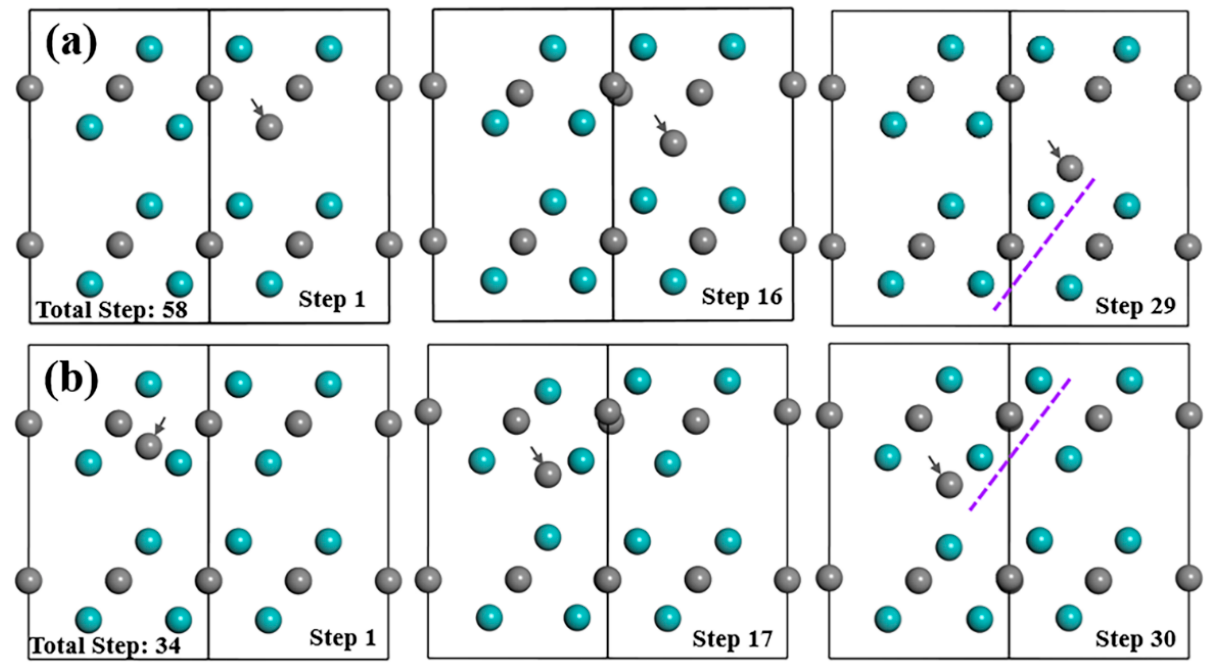
Figure 3. Structure evolution of Mo 2 C supercell with ( a ) S C and ( b ) I C (II) during optimization process. Cyan and grey balls represent Mo and C atoms, respectively; grey arrows refer to the defect atom.